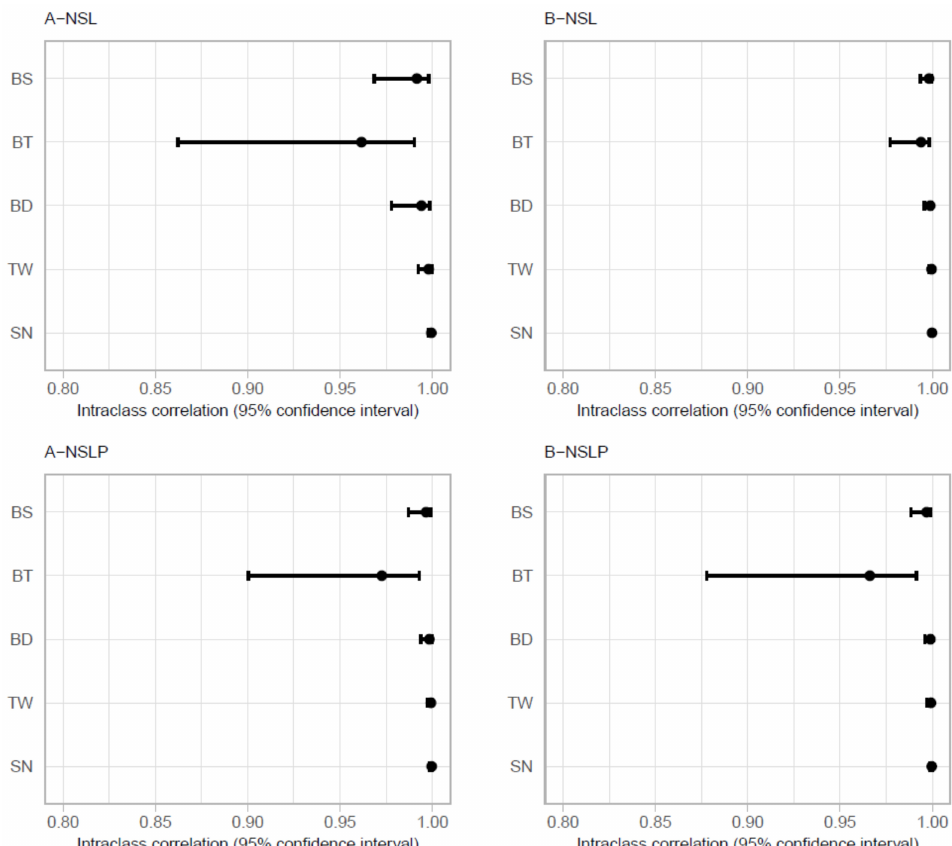
Figure 3. ICC values for the BD, BT, BS, TW, and SN methods presented for four variables: vertical and horizontal distances of the landmarks A and B and to the horizontal (NSL) and vertical (NSLP) reference lines,